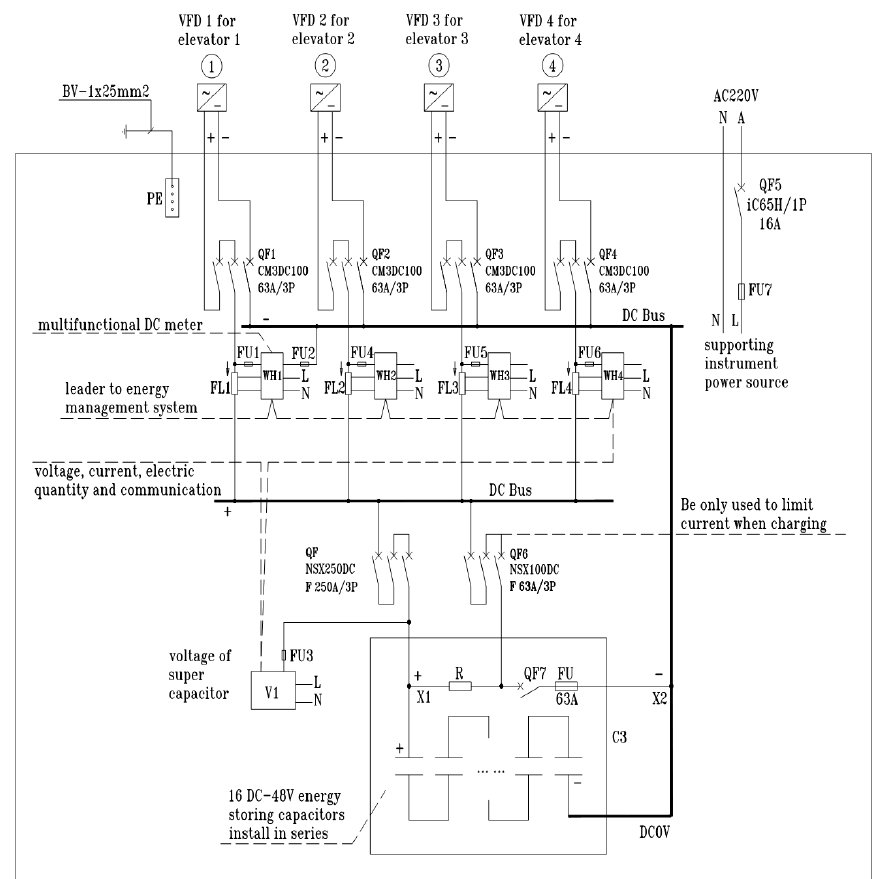
Figure 7. The design of the elevator DC micro-grid [47].